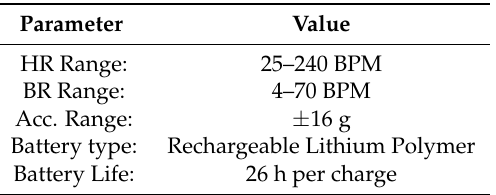
Table 1. Bioharness 3